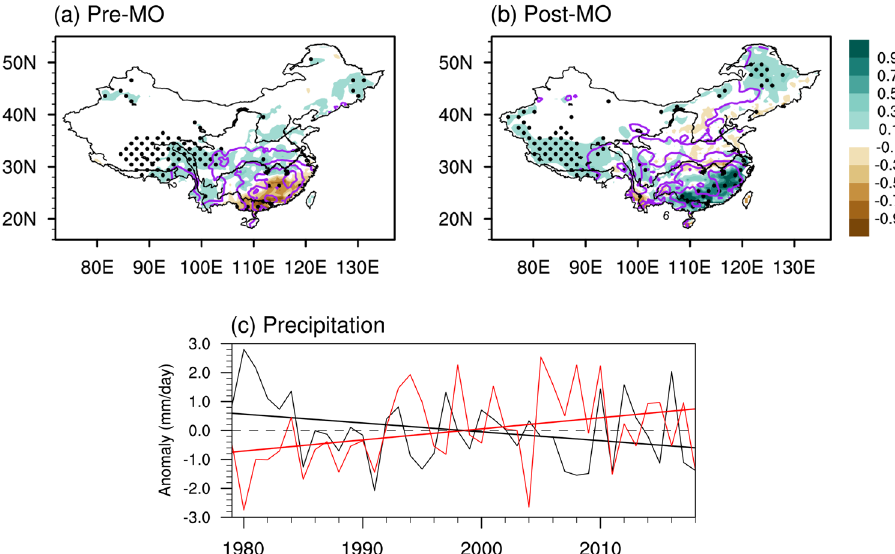
Fig. 1 Contrasting precipitation trends in early summer over southern China. Precipitation trends in a 1 April – 15 May (the pre-monsoon onset period (pre-MO)) and b 16 May – 30 June (the post-monsoon onset period (post-MO)) over China in 1979 – 2018 (shading, mm/day/ decade). Purple contours indicate the corresponding climatology of daily precipitation in 1979 – 2018 (mm; referring to 2, 4, 6, and 8 mm/day from north to south). Stippled areas are signi fi cant at the 0.1 level in a and at the 0.05 level in b . c Time series of areal-mean precipitation anomalies (mm/day) over southern China (SC, 20 – 28°N/105 – 120°E) in the pre-MO period (black curve) and the post-MO period (red curve). Slanted solid lines are the corresponding linear regressions with coef fi cients of − 0.31 and + 0.38 mm/day/decade, signi fi cant at the 0.1 and 0.05 levels,